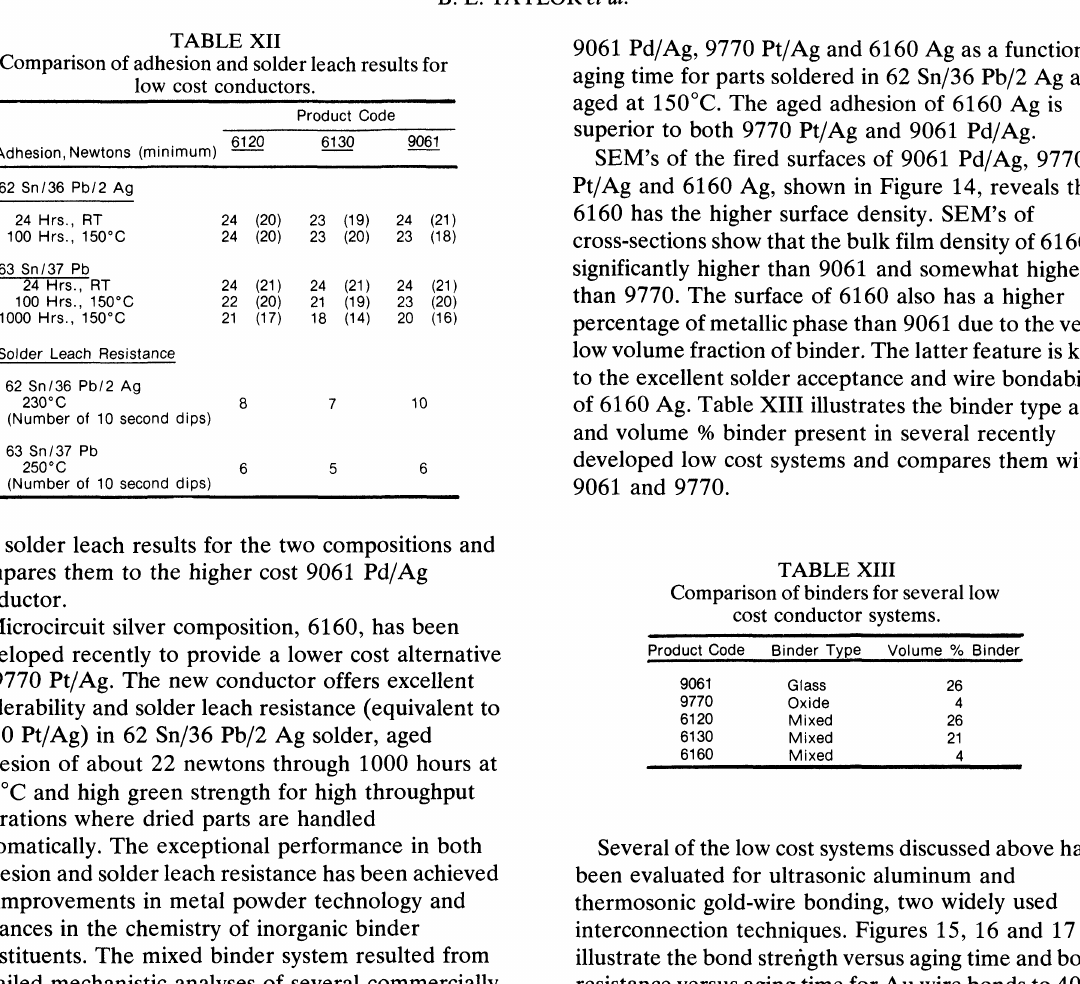
TABLE XII Comparison of adhesion and solder leach results for low cost conductors.